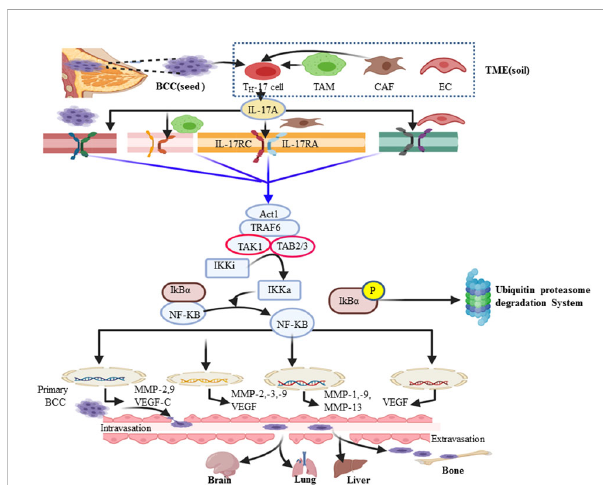
FIGURE 2 An overview of the IL-17A/MAPK signaling pathway in the proliferation of breast cancer. ERK1/2, JNK, and p38 MAPK are the major effector molecules of this signal cascade and lead to phosphorylate multiple transcription factors, particularly activator protein one (AP-1), which is a hetero-dimeric composition of c-Jun and c-Fos proteins. Once active, it translocates to the nucleus and orchestrates the expression and function of many proliferative genes or cell cycle regulators such as cyclin D1 (G1-to-S phase) and cyclin A/E (S-to-G2 phase). In turn, it increases cell growth or proliferation and survival.